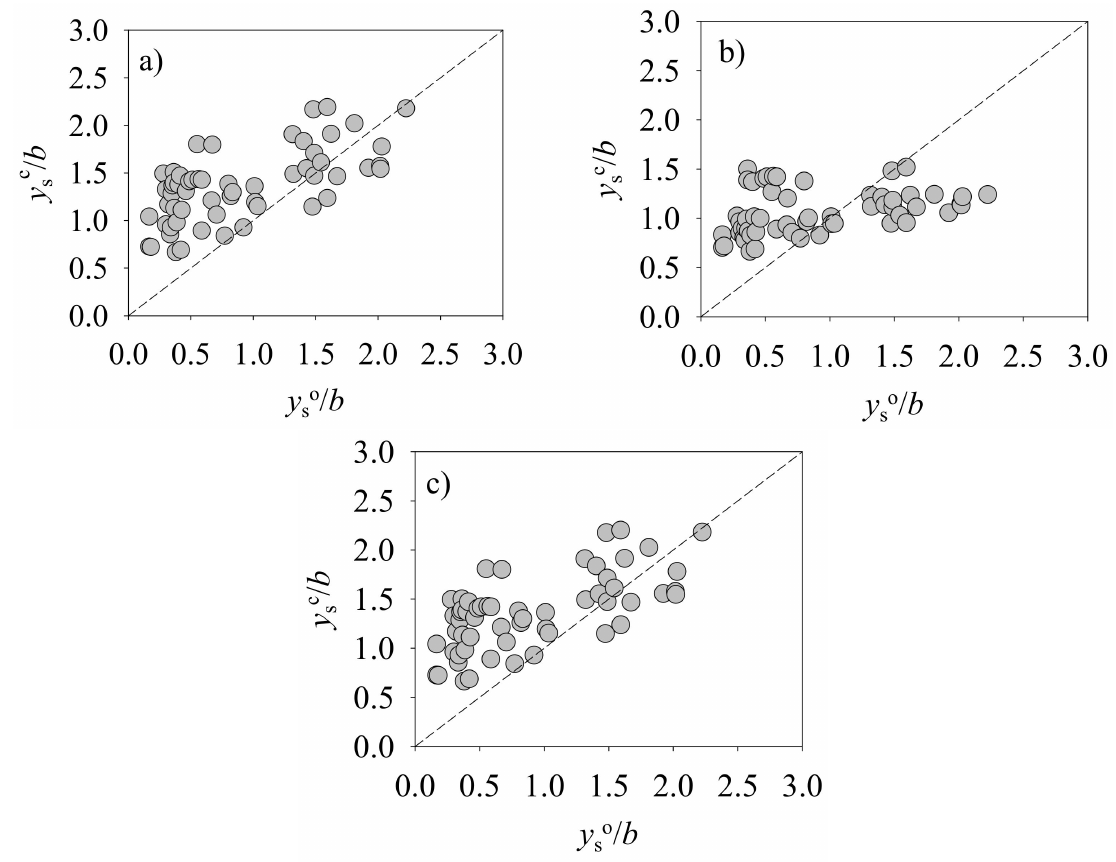
Figure 3. Comparison of the nondimensional observed scour depth, y so / b , and the nondimensional calculated scour depth, y sc / b , for the selected hybrid models: ( a ) YJAF-VRAD, ( b ) YJAI-VRAD, and ( c ) YJAF-VARN (- - - - - - -) perfect agreement